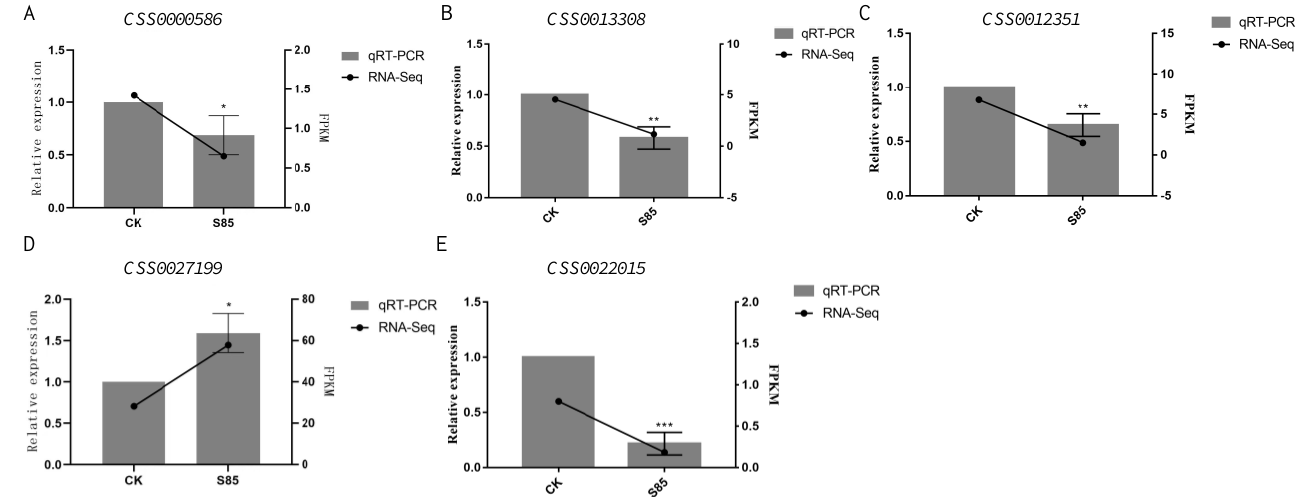
Figure 8. Validation of the differentially expressed genes by a qRT-PCR analysis. Significant differ- ences between CK and S85 are indicated (* p < 0.05, ** p < 0.01 and *** p < 0.001).